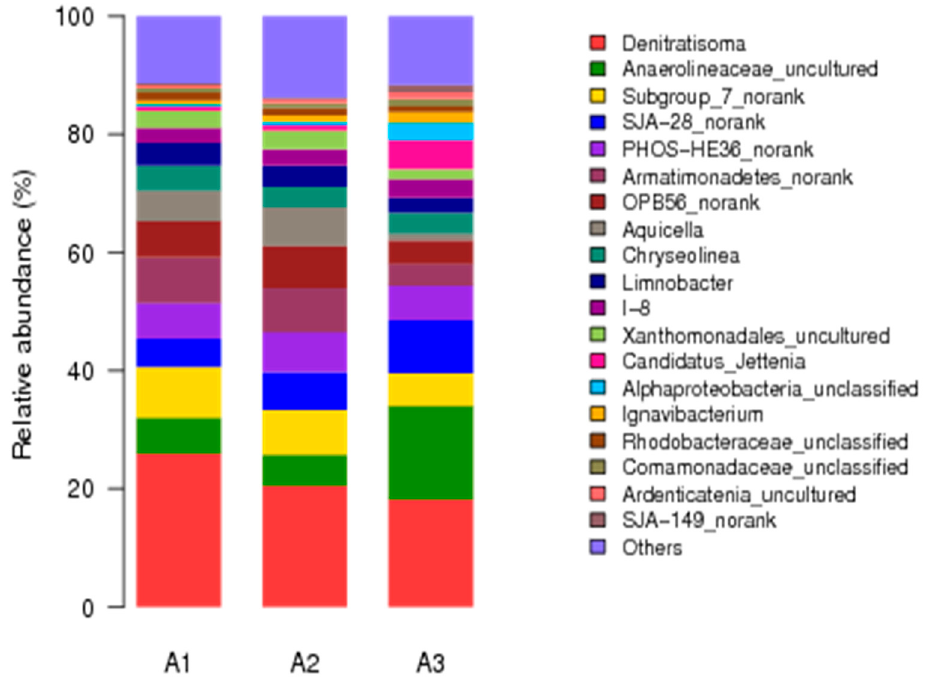
Figure 5. Top 19 genera in samples collected on day 1 ( A1 ), day 13 ( A2 ), and day 79 ( A3 ).